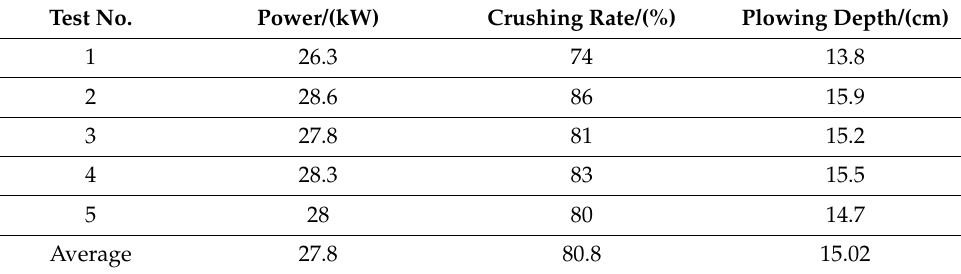
Table 6. Experiment A measurement results.